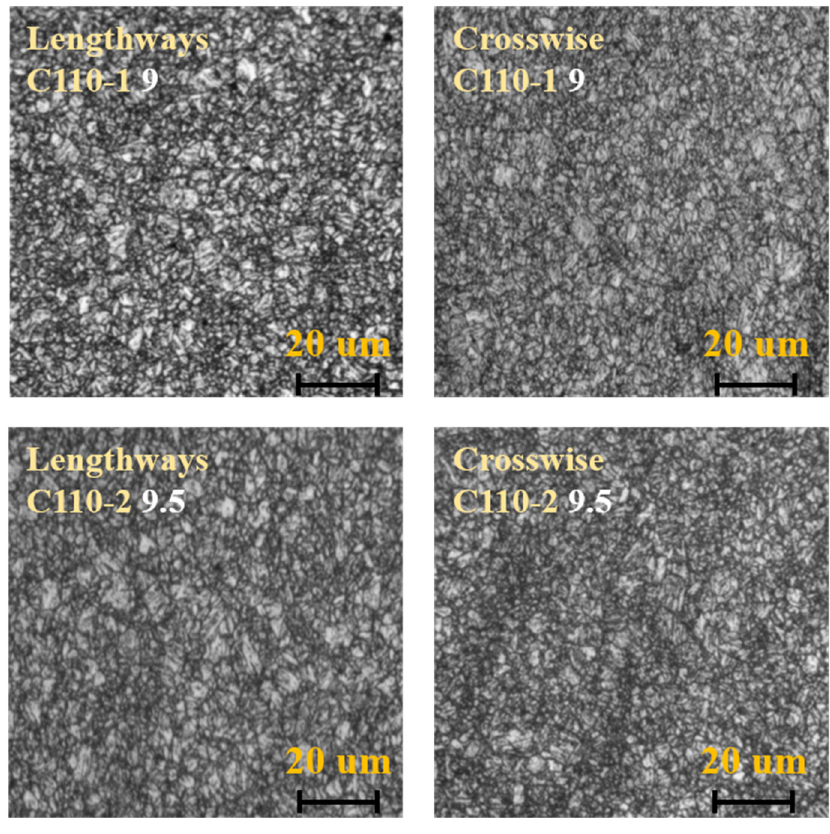
Figure 8. Grain size of C110-1 and C110-2.